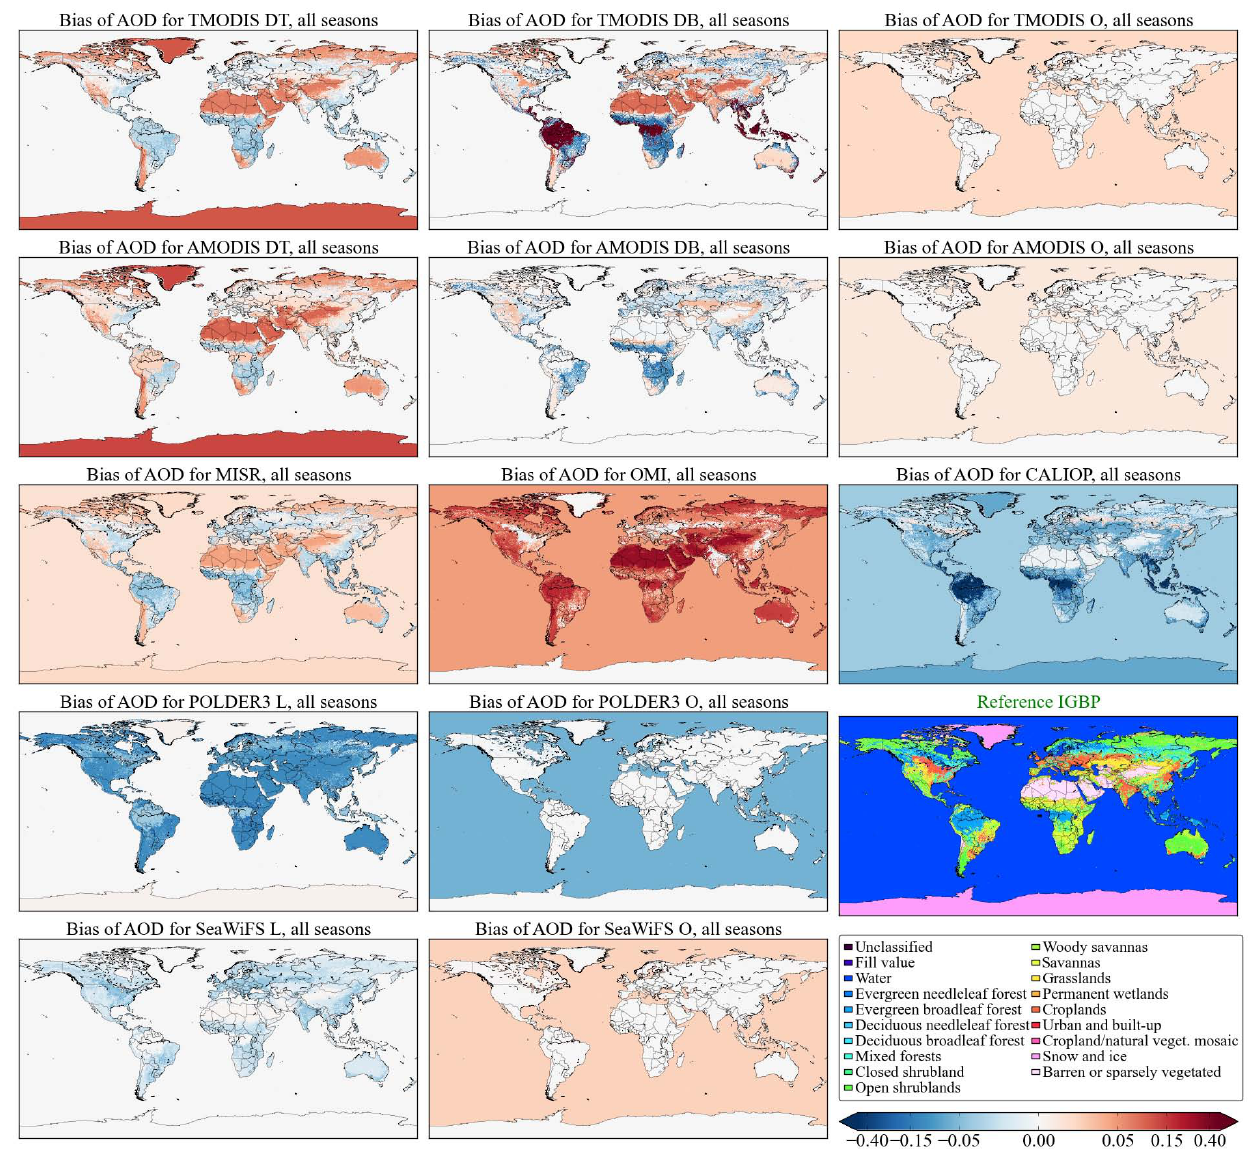
Fig. 15. Land cover type dependence of bias between the collocated spaceborne and ground-based (AERONET) observations of AOD. Areas corresponding to each IGBP land cover type (bottom right inset) are colored based on the average of the data from those AERONET sites that reside in these areas. The statistics were calculated based on the data that were pre-filtered by QA and screened of outliers as described in Sects. 4 and